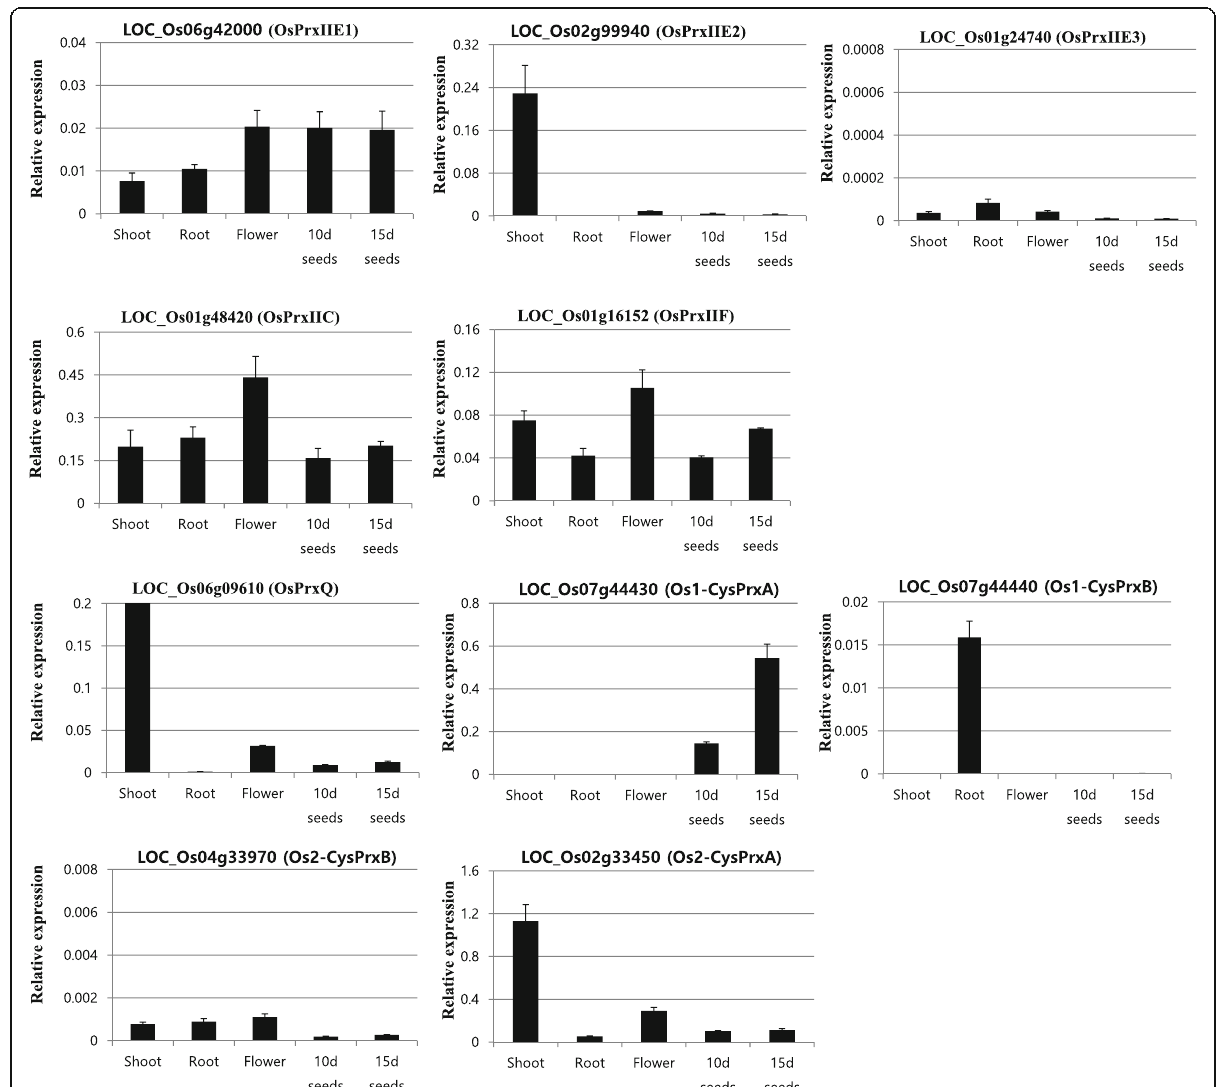
Fig. 2 Validation of meta-expression patterns in six tissues/organs for 10 PRX genes in rice based on qRT-PCR analysis of samples from seedling shoots, roots, flowers, seeds at 10 DAP, and seeds at 15 DAP. Rice ubiquitin 5 (OsUbi5, LOC_Os01g22490 ) was used as internal control. Y-axis, expression level relative to OsUbi5 ; X-axis, samples used for